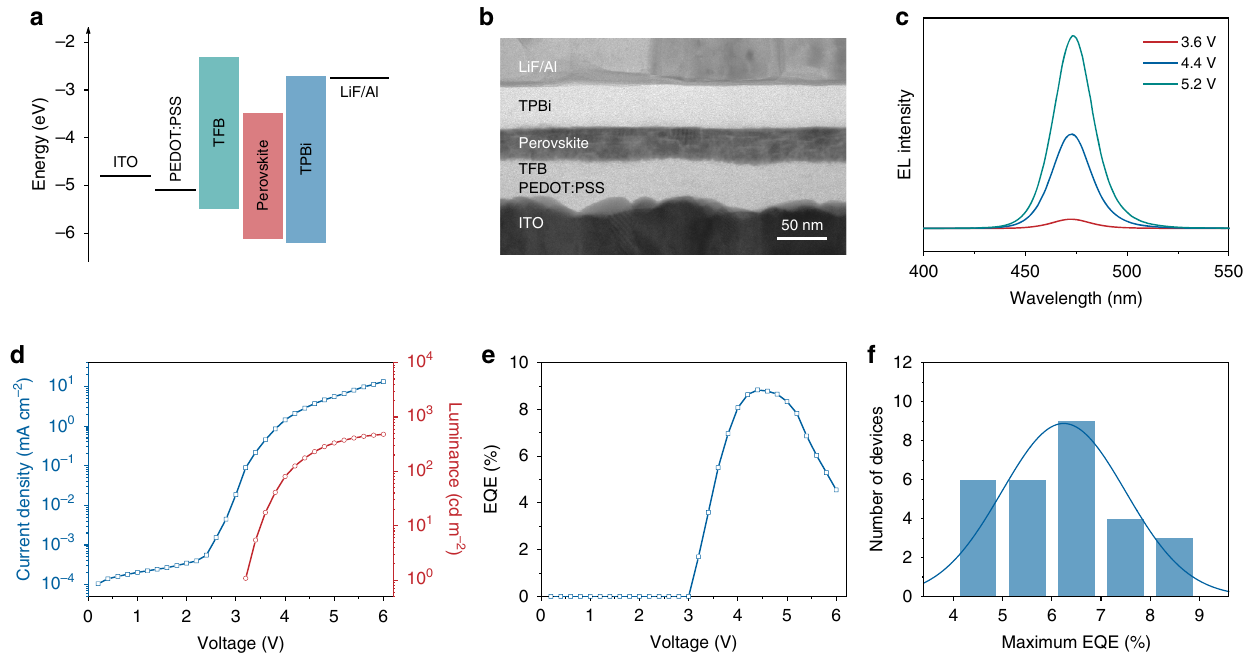
Fig. 5 Characteristics of blue PeLEDs. a Energy level diagram of the EL devices. b Cross-sectional TEM image of the multi-layered EL device. c EL spectra under forward biases of 3.6, 4.4, and 5.2 V. d Current density – luminance – voltage characteristic of the best-performance device. e EQE – voltage characteristic of the best-performance device. f Histogram of maximum EQEs from 28